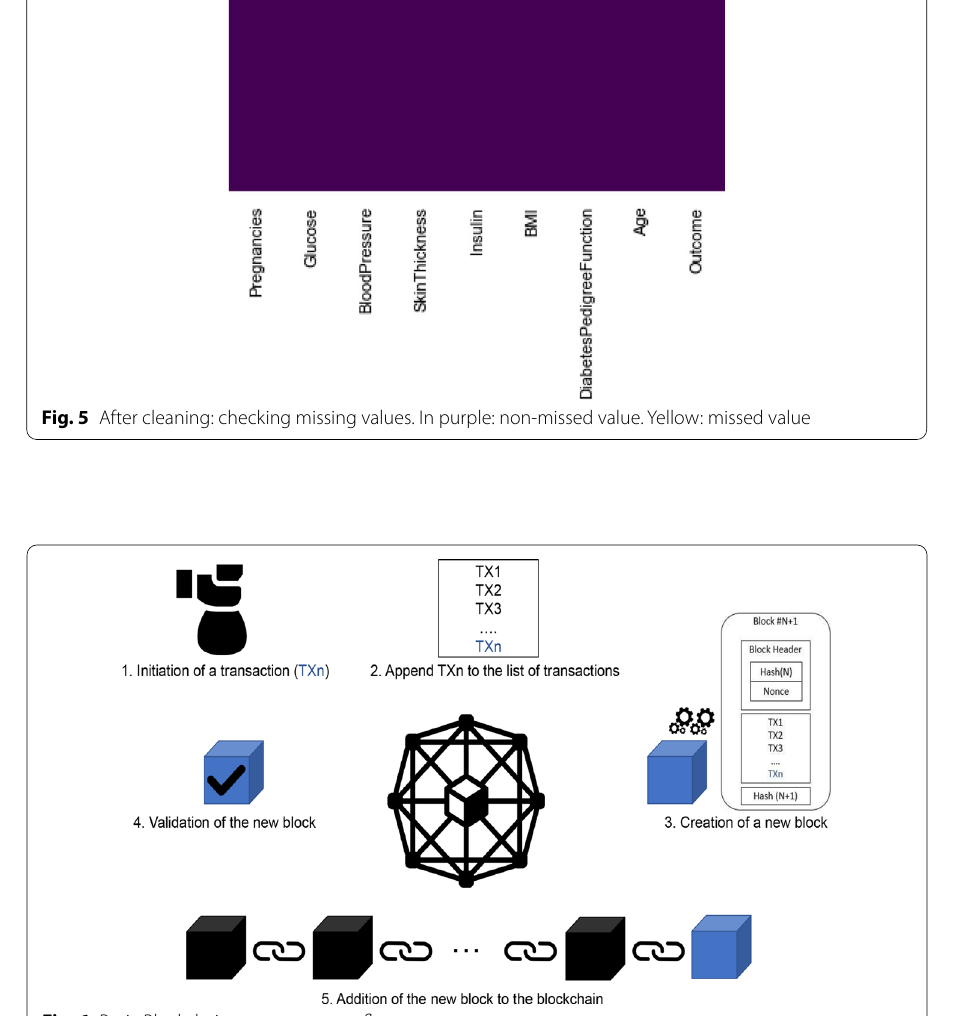
Fig. 6 Basic Blockchain storage process